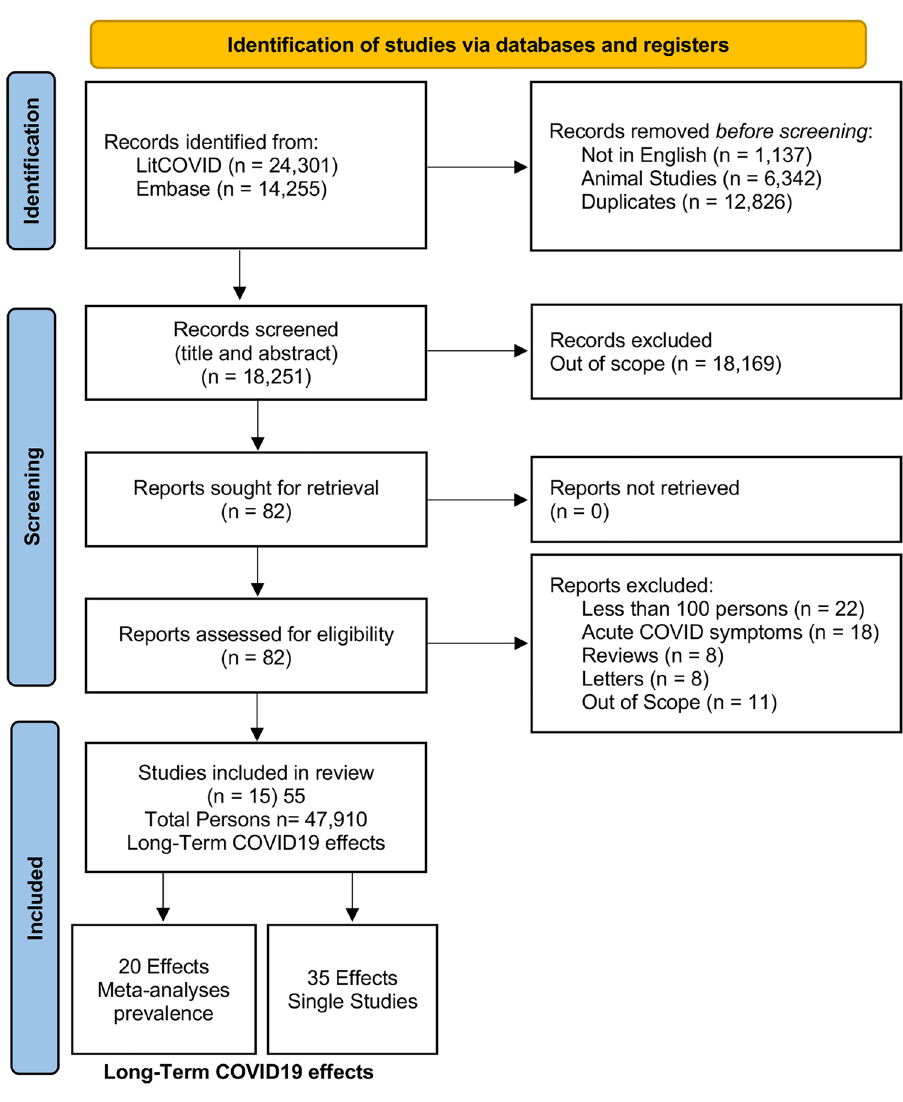
Figure 1. Study selection. Preferred items for Systematic Reviews and Meta-Analyses (PRISMA) flow diagram. Out of 15,917 identified studies and after application of the inclusion and exclusion criteria, 15 studies were included in the quantitative